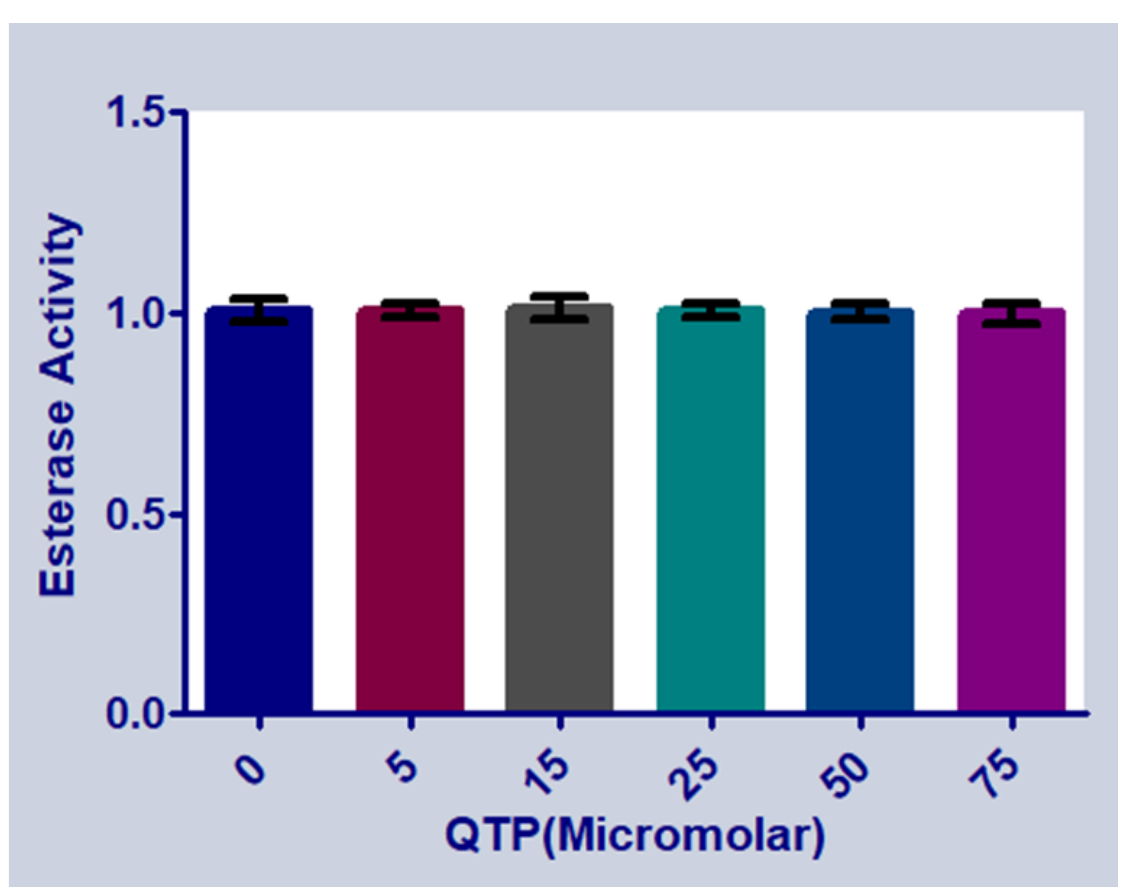
Figure 8. Estimated ester ase activity in HSA (5 μM) in the absence and presence of increasing concentrations of QTP (0 –75 μM).